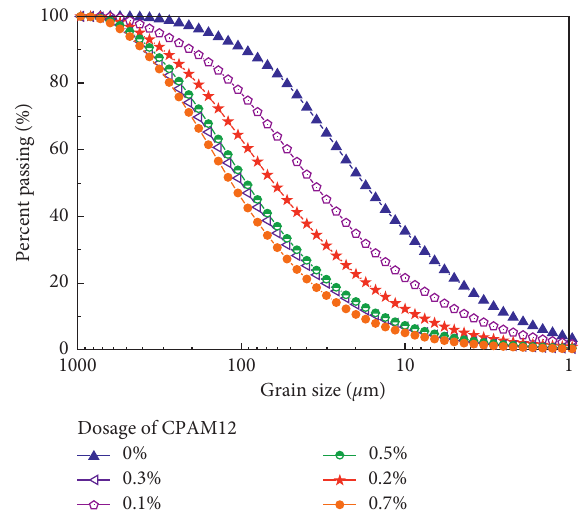
Figure 13: Grain size distribution of the slurry with different dosages of CPAM12. Table 5: Summarized measurements of slurry aggregate size after adding different dosages of CPAM12.